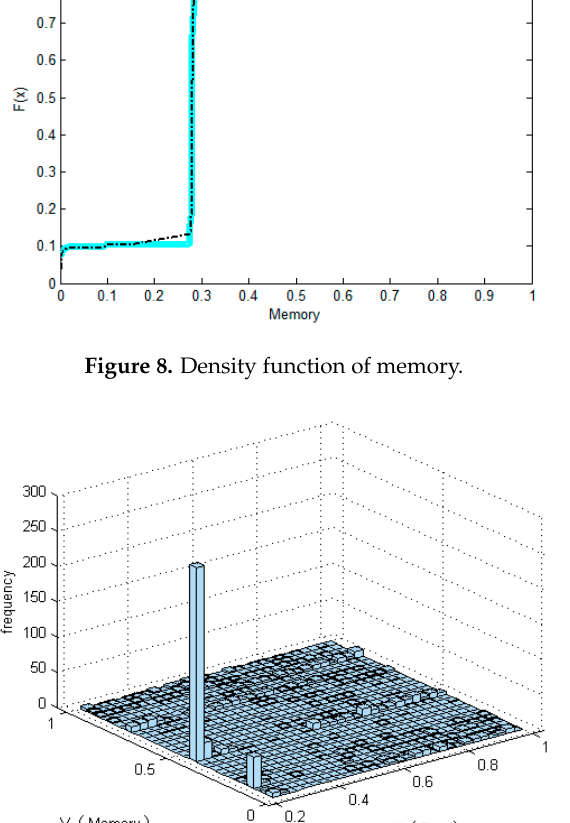
Figure 9. Bi-histogram of memory and flow.